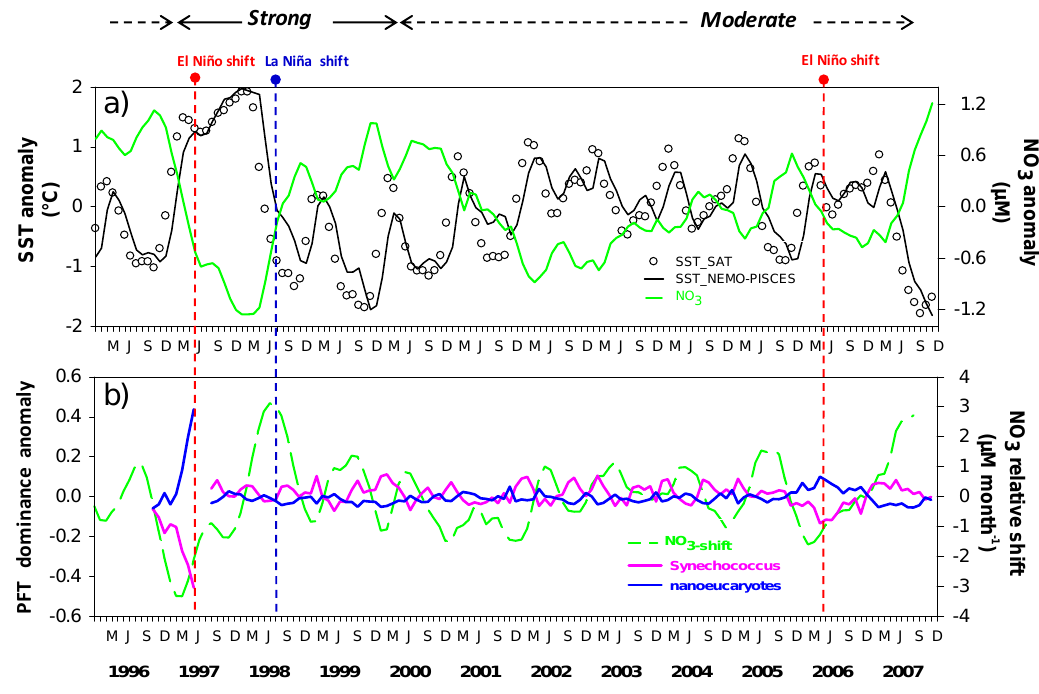
Fig. 7. The temporal evolution between 1996-2007 of the anomalies in (a) Sea-Surface-Temperature (SST) and nitrate (NO 3 ) and (b) Syne- chococcus and nanoeucaryotes. In addition, panel (b) also includes the relative shift in nitrate (NO 3 - shift ) in the Equatorial Pacific region (10 ◦ N–10 ◦ S, 180 ◦ W–80 ◦ W). The relative shift in nitrates (NO 3 - shift ) in panel (b) corresponds to time derivative of surface NO 3 concen- trations obtained from the NEMO-PISCES model. The SST in panel a was obtained from either satellite (SST SAT) or the NEMO-PISCES model (SST NEMO-PISCES). Vertical dashed lines correspond to the onsets of El Ni˜no (red) and La Ni˜na (blue) periods associated to the main PFT shifts (cf. Fig. 5e and